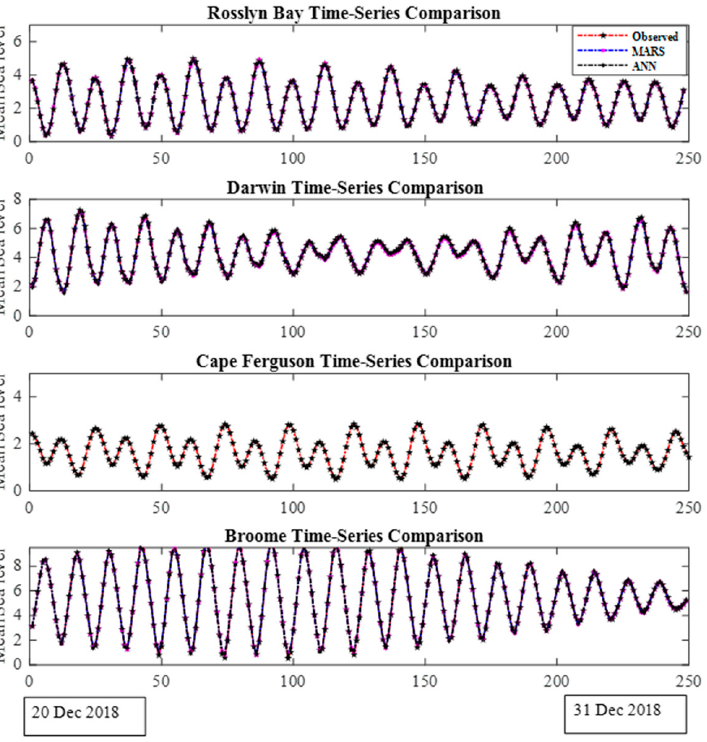
Figure 12. Time series plot shows the predicted MARS and ANN data points with observed data.